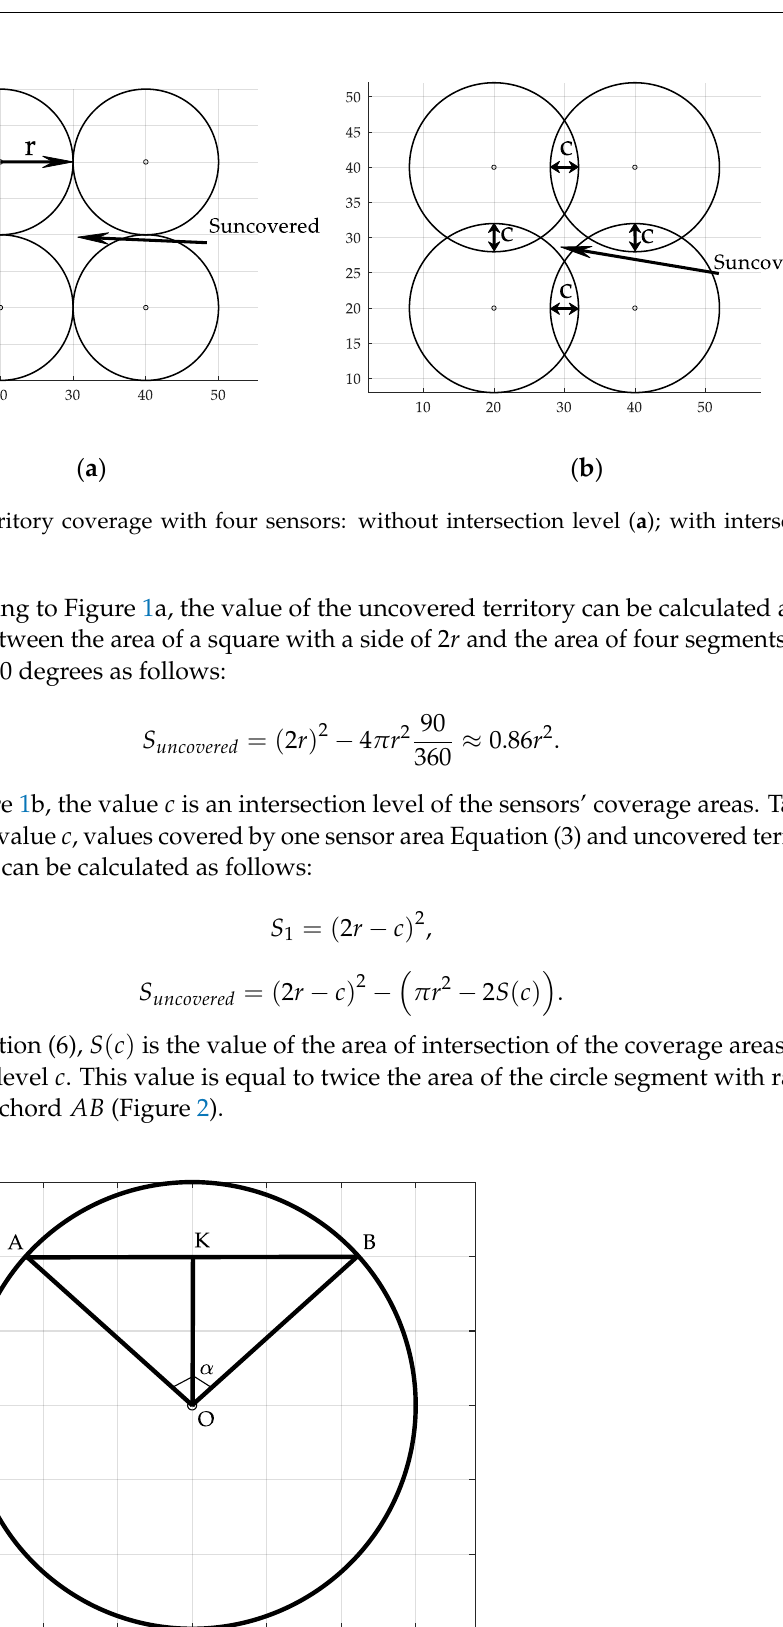
Figure 1. Territory coverage with four sensors: without intersection level ( a ); with intersection level ( b ).